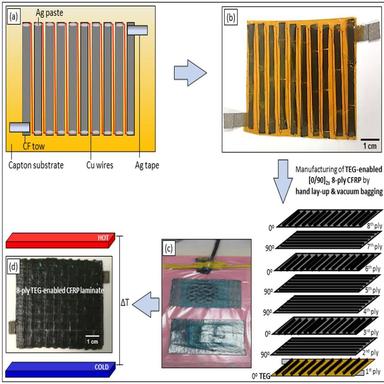
(a) Cartoon of the CF-based TEG module with ten (10) p-type serially interconnected CF-M40B thermocouples, (b) the real device on a kapton substrate, (c) the vacuum bagging process for the manufacturing of 3D TEG-enabled CFRP, followed by thermopressing and curing/post-curing, as well as the cartoon of the TEG enabled CFRP with a 2s symmetric configuration, (d) the final TEG-enabled CFRP and demonstration of an in-plane temperature difference (ΔT).